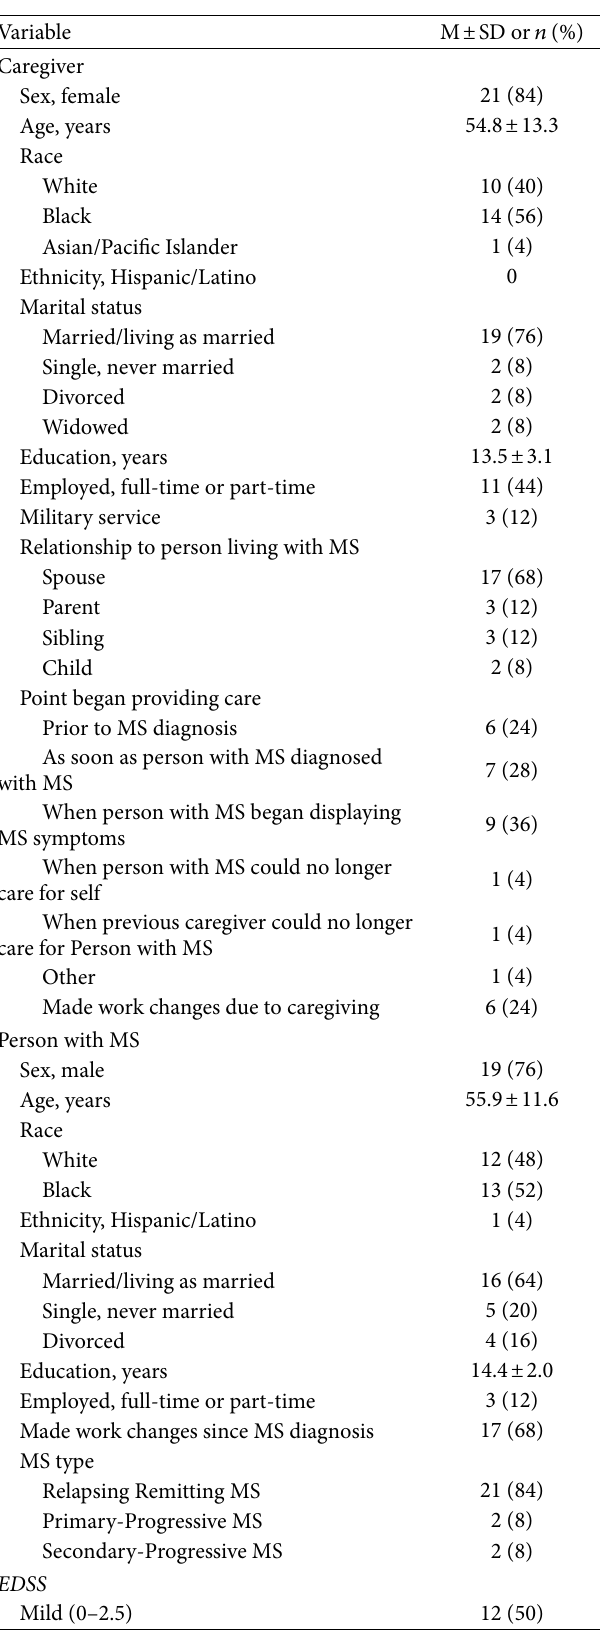
Table 1: Demographics of caregivers ( 푛 = 25 ) and persons with MS ( 푛 = 25 ).